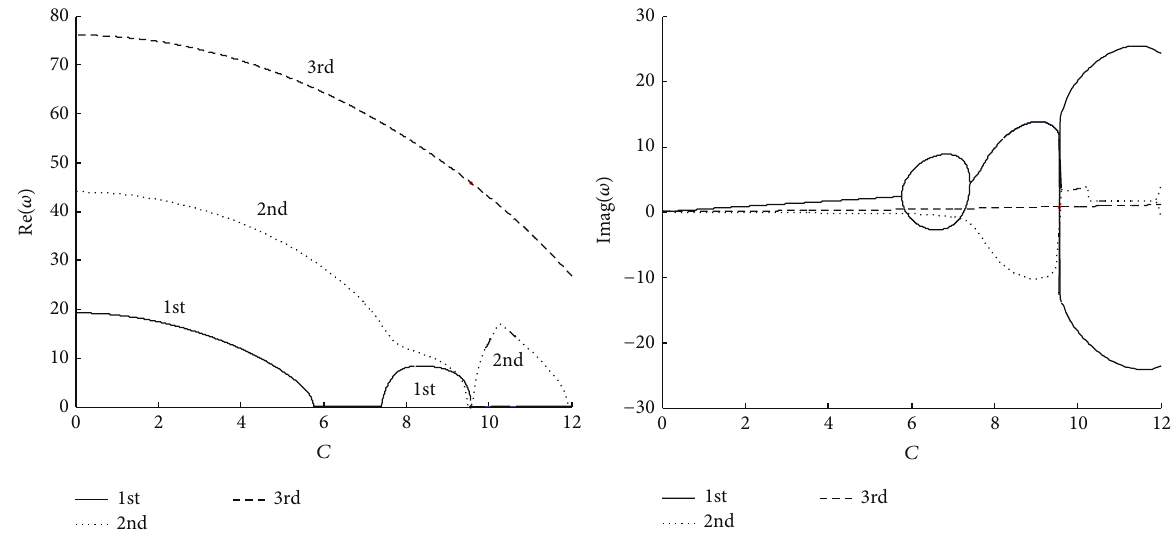
Figure 3: Dimensionless complex frequencies versus dimensionless axially moving speed 𝐶 ( 𝐻 = 10 −5 , 𝑞 = 50 , 𝑟 = 1 , 𝑈 = 10 , and 𝜆 = 0.05 ).